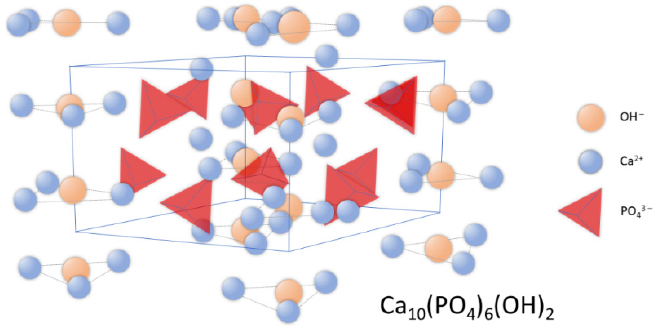
Figure 1. Schematic representation of hydroxyapatite’s crystal structure.